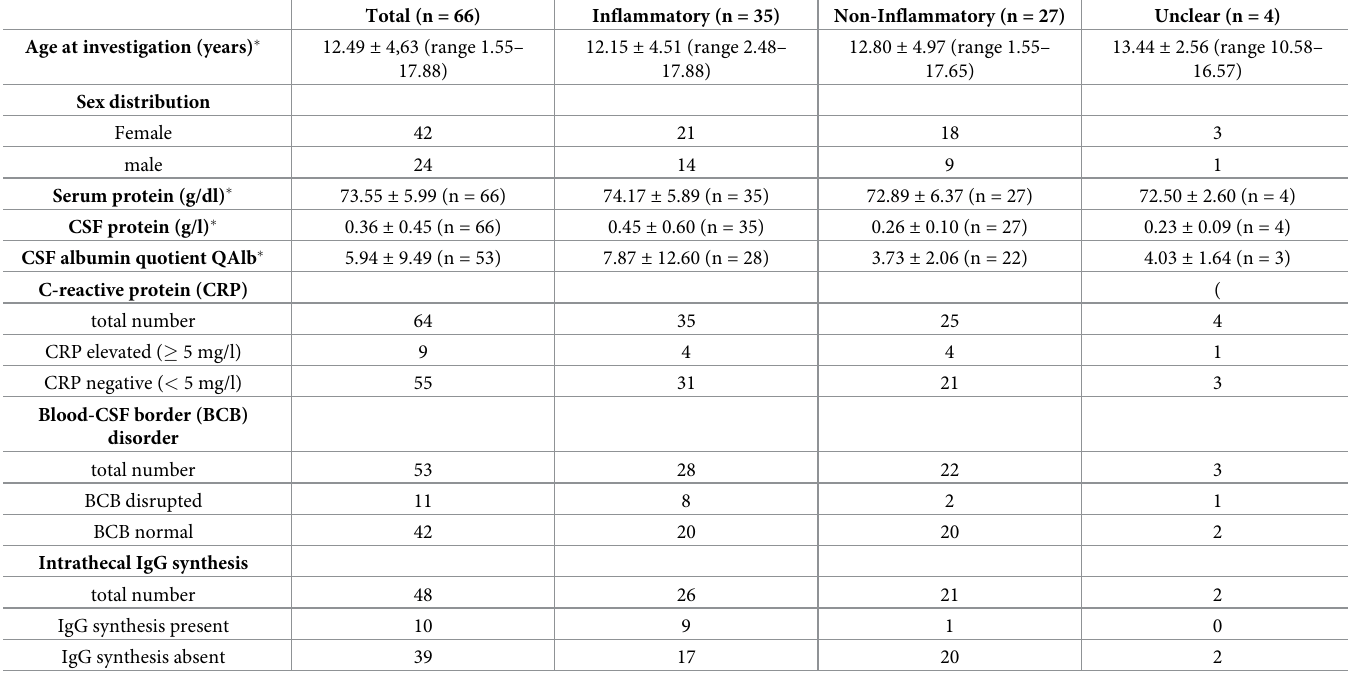
Table 1. Clinical data of samples for measurement of fetuin-A in CSF and serum with ELISA.